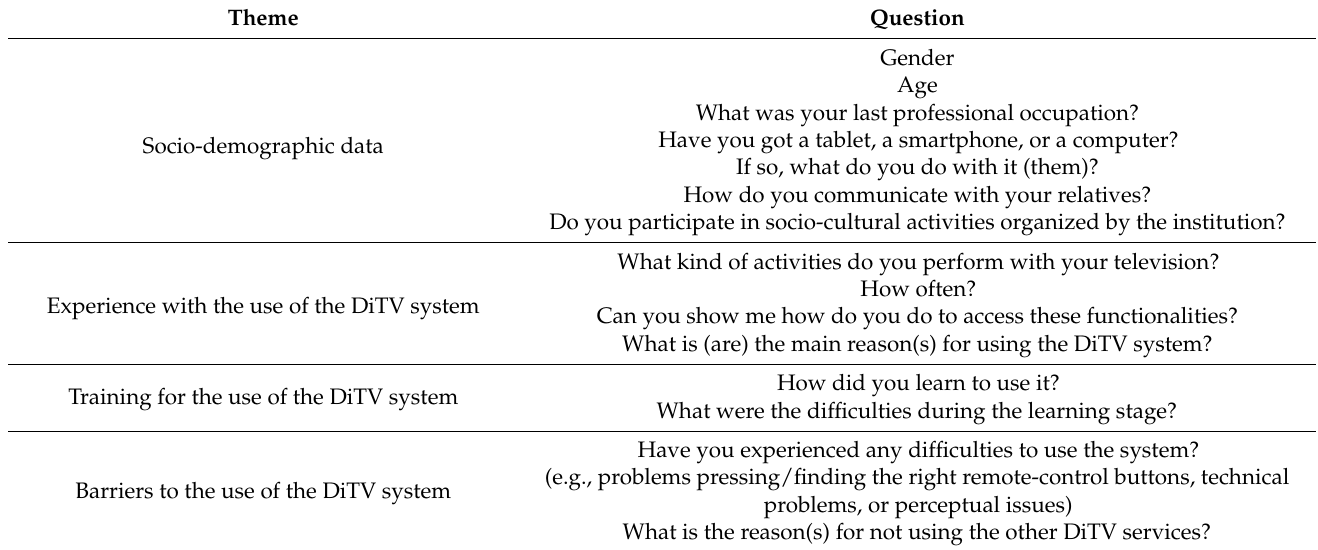
Table 1. Interview guide used for semi-structured interviews with